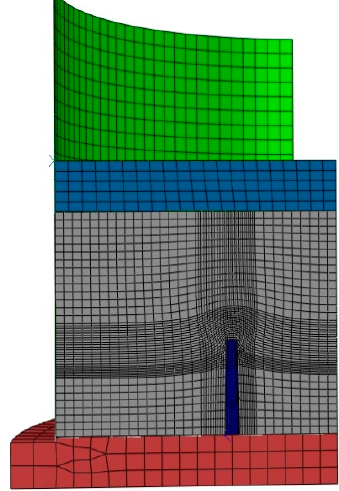
Figure 26. The deformed mesh of the compaction test with the Figure 24. The deformed mesh of the compaction test with the slot. Figure 24. The deformed mesh of the compaction test with the slot.